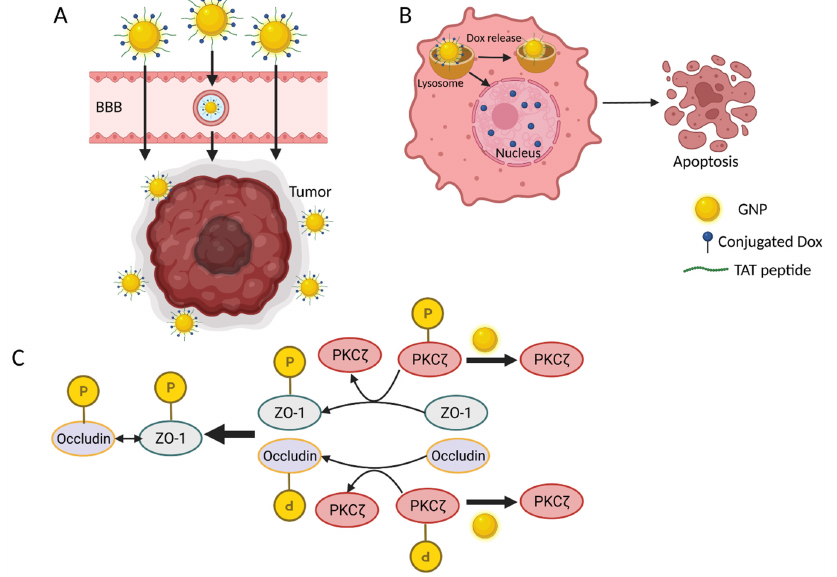
Figure 3. Transport of GNPs to tumor cells. ( A ) Gold NPs carrying the chemotherapeutic agent dox- orubicin and the TAT peptide can cross the BBB through paracellular transport and AMT to reach tumor cells. The GNPs accumulate at the tumors via the enhanced permeability and retention effect. ( B ) After internalization by the tumor cell, the GNPs are transported into lysosomes, where doxo- rubicin is released from its hydrazone linkage by the acidic microenvironment. The doxorubicin enters the nucleus and damages DNA by acting as an intercalator, resulting in apoptosis of tumor cells. ( C ) GNPs improve paracellular transport across the BBB by decreasing the level of phosphor- ylated PKC ζ , an enzyme required for the proper association between ZO-1 and occluding at the tight junctions of endothelial